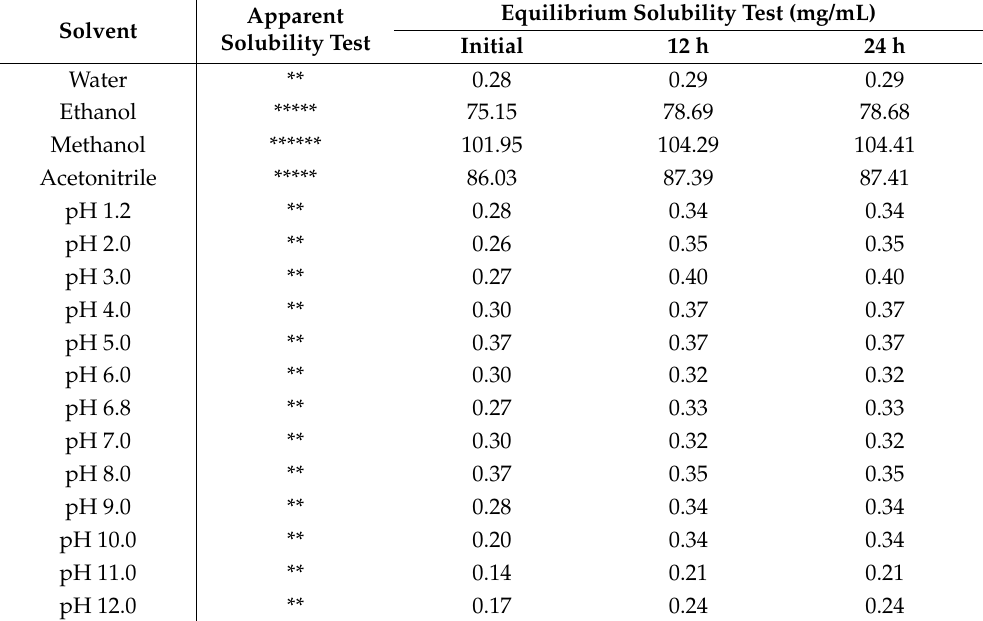
Table 4. Solubility of dapagliflozin propanediol hydrate in various